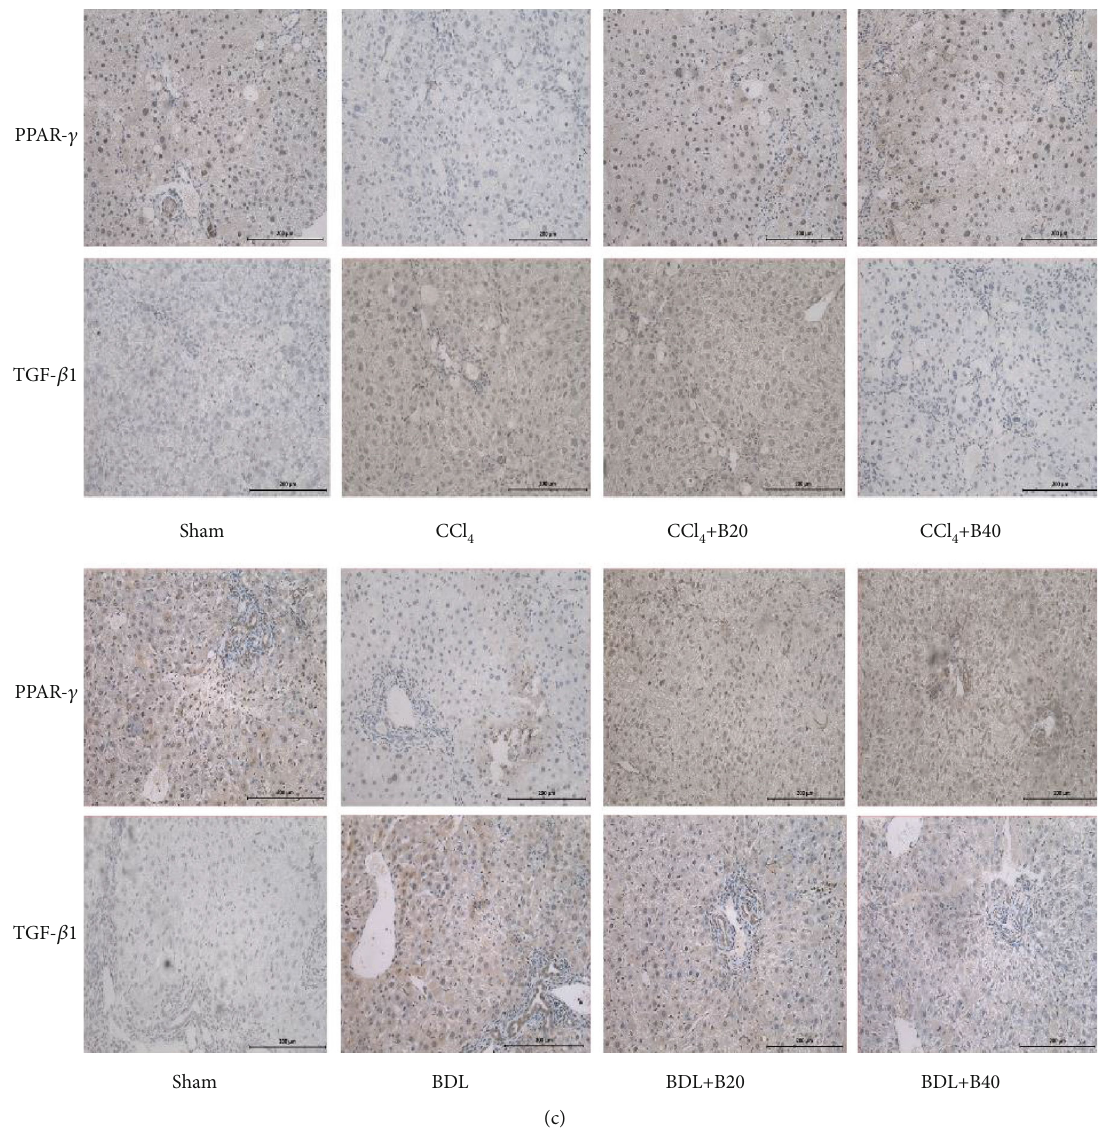
Figure 4: Bergenin inhibits the TGF- β 1/Smads pathway by activating PPAR- γ . (a) mRNA expression of PPAR- γ and TGF- β 1 assessed by real-time PCR ( n = 8 ). (b) Protein expression of PPAR- γ and TGF- β 1 assessed by western blotting. The quantitative evaluation was determined by relative band density. (c) Immunohistochemical staining of PPAR- γ and TGF- β 1 (original magnification = 200x ). ∗ p < 0 : 05 for CCl /BDL vs. sham, # p < 0 : 05 for CCl /BDL+B20 vs. CCl /BDL, and ^ p < 0 : 05 for CCl /BDL+B40 vs. CCl 4 4 4 4 4